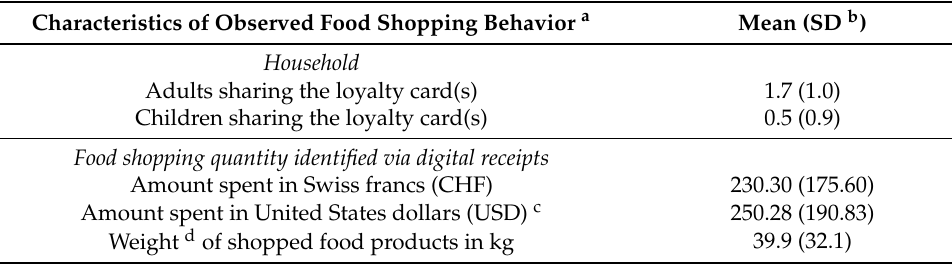
Table 3. Food shopping characteristics of the study sample, N = 89. Characteristics of Observed Food Shopping Behavior